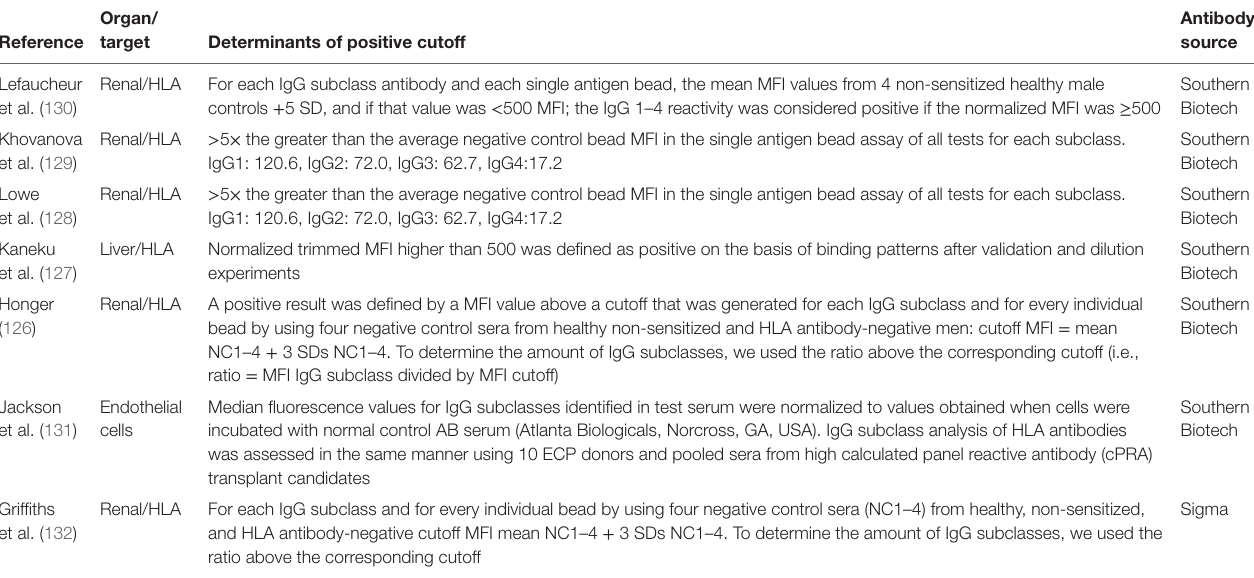
TABLe 2 | Summary of different methods for detecting igG subclasses against HLA and non-HLA targets. Organ/ Reference target Determinants of positive